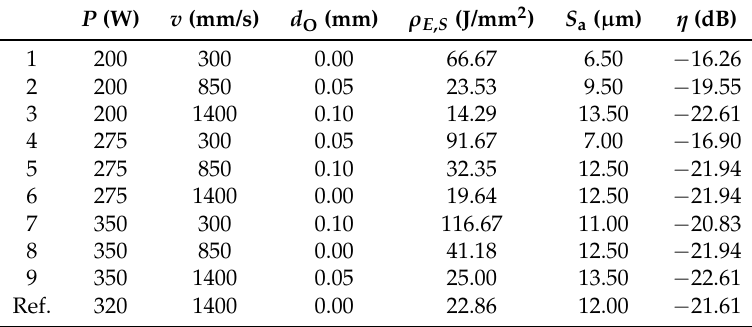
Table 4. Factors and their respective levels for the nine experiments regarding contour and reference with manufacturers’